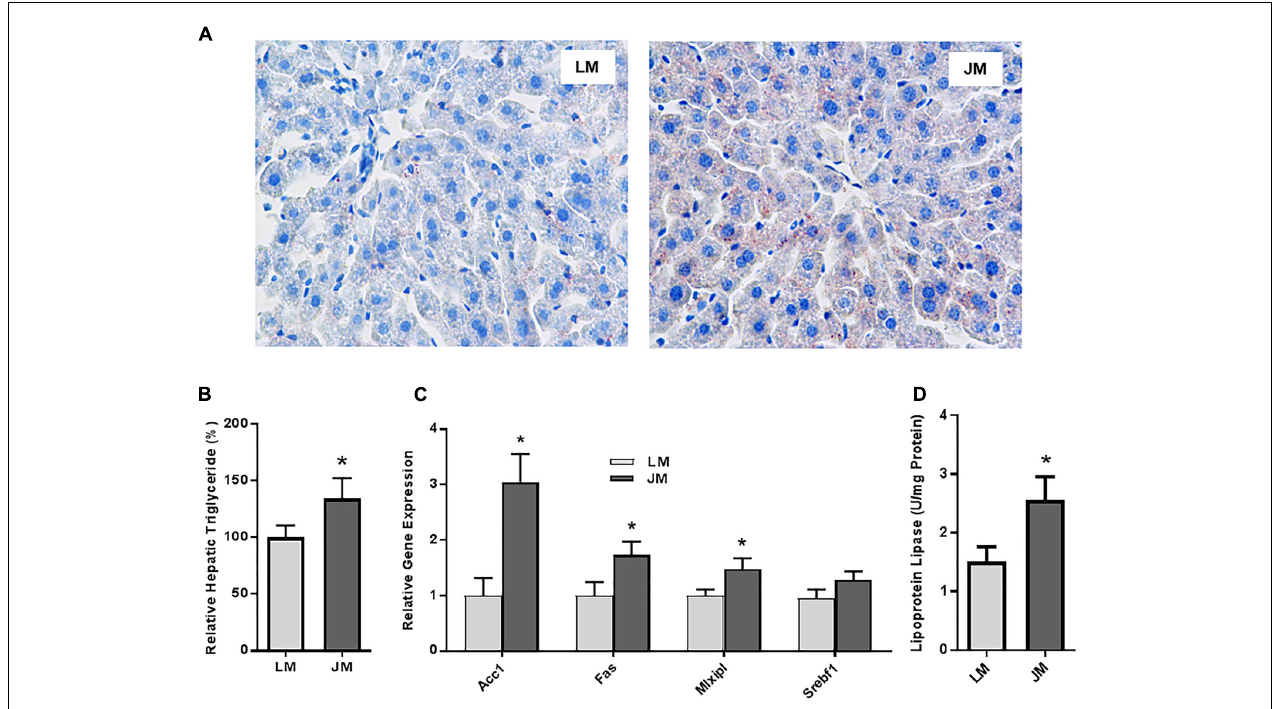
FIGURE 8 | Fat deposition and lipogenesis in the liver of mice transplanted with Landrace and Jinhua pig microbiota. (A) Representative pictures of the liver sections of mouse recipients stained with Oil Red O. Neutral lipids appear in red (magnification: 400 × ). (B) Relative triglyceride content (%) in the liver of mouse recipients. (C) Relative expression levels of several major lipogenic genes in the liver of mouse recipients. (D) The lipoprotein lipase activity in the liver of mouse recipients. The results were shown as means ± SEM of 12 mice. ∗ P < 0.05 (by unpaired Student’s t -test). LM, mice receiving fecal microbiota from Landrace pigs; JM, mice receiving fecal microbiota from Jinhua